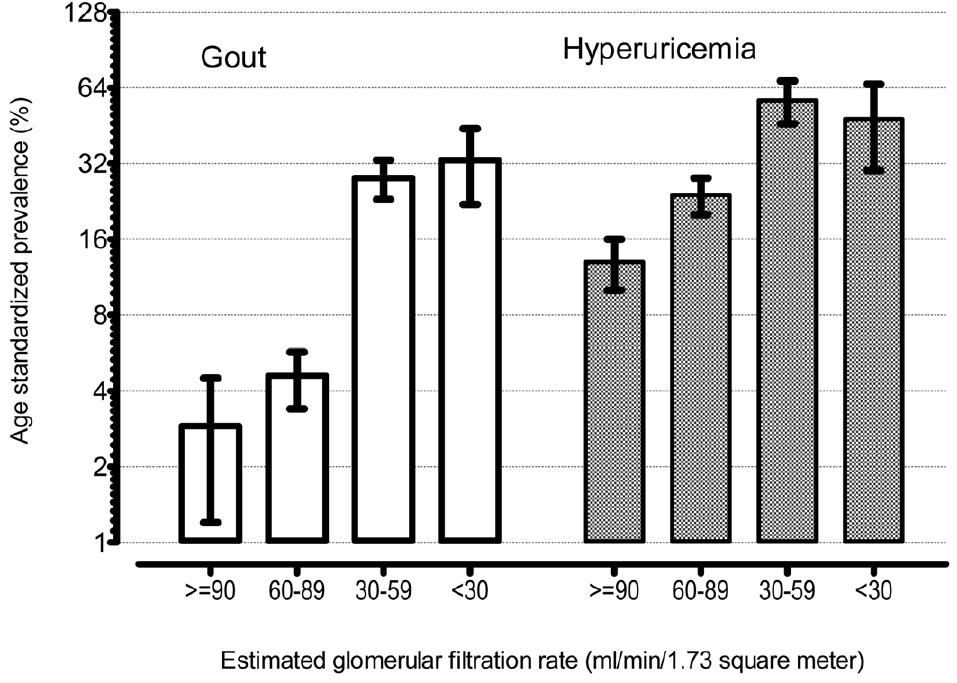
Figure 1. Age-standardized prevalence rates of gout and hyperuricemia. Gout was defined as self-reported physician/provider diagnosis. Hyperuricemia was defined as serum urate . 7.0 mg/dL for men and . 6 mg/dL for women. Trend tests performed by survey weighted logistic regressions where age and estimated glomerular filtration rates were utilized as continuous measures were statistically significant in both the cases (p , 0.001). Conversion factors for units: serum urate in mg/dL to m mole/L, 6